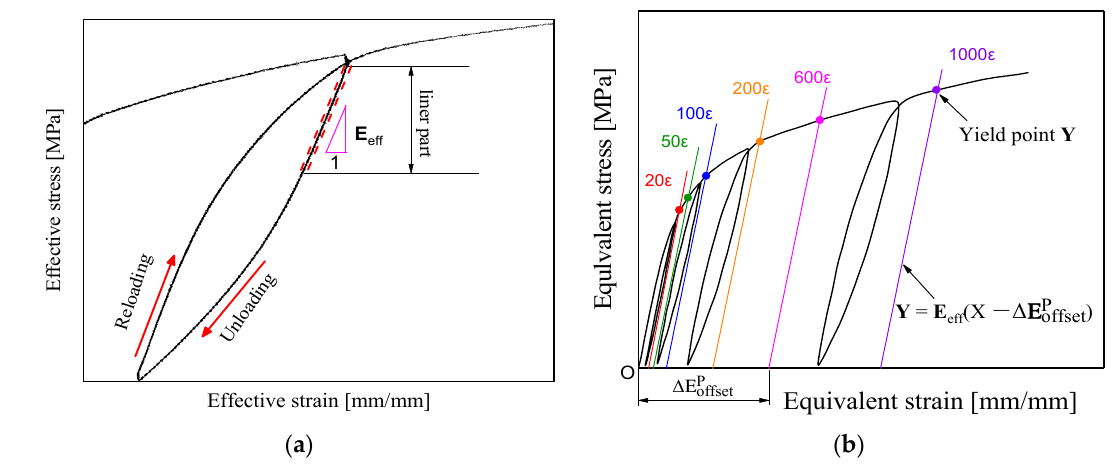
Figure 4. The yield point definition in terms of unloading modulus: ( a ) the determination method of unloading stiffness; ( b ) the variation of unloading stiffness E eff with the increasing offset strain during reloading and unloading processes.